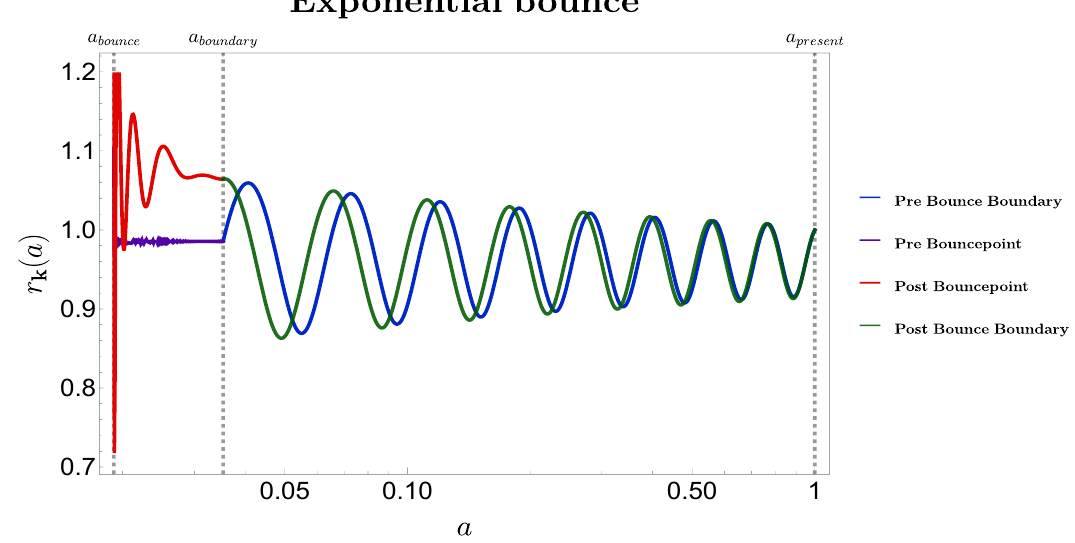
Figure 26: Squeezing parameter at different regions plotted against scale